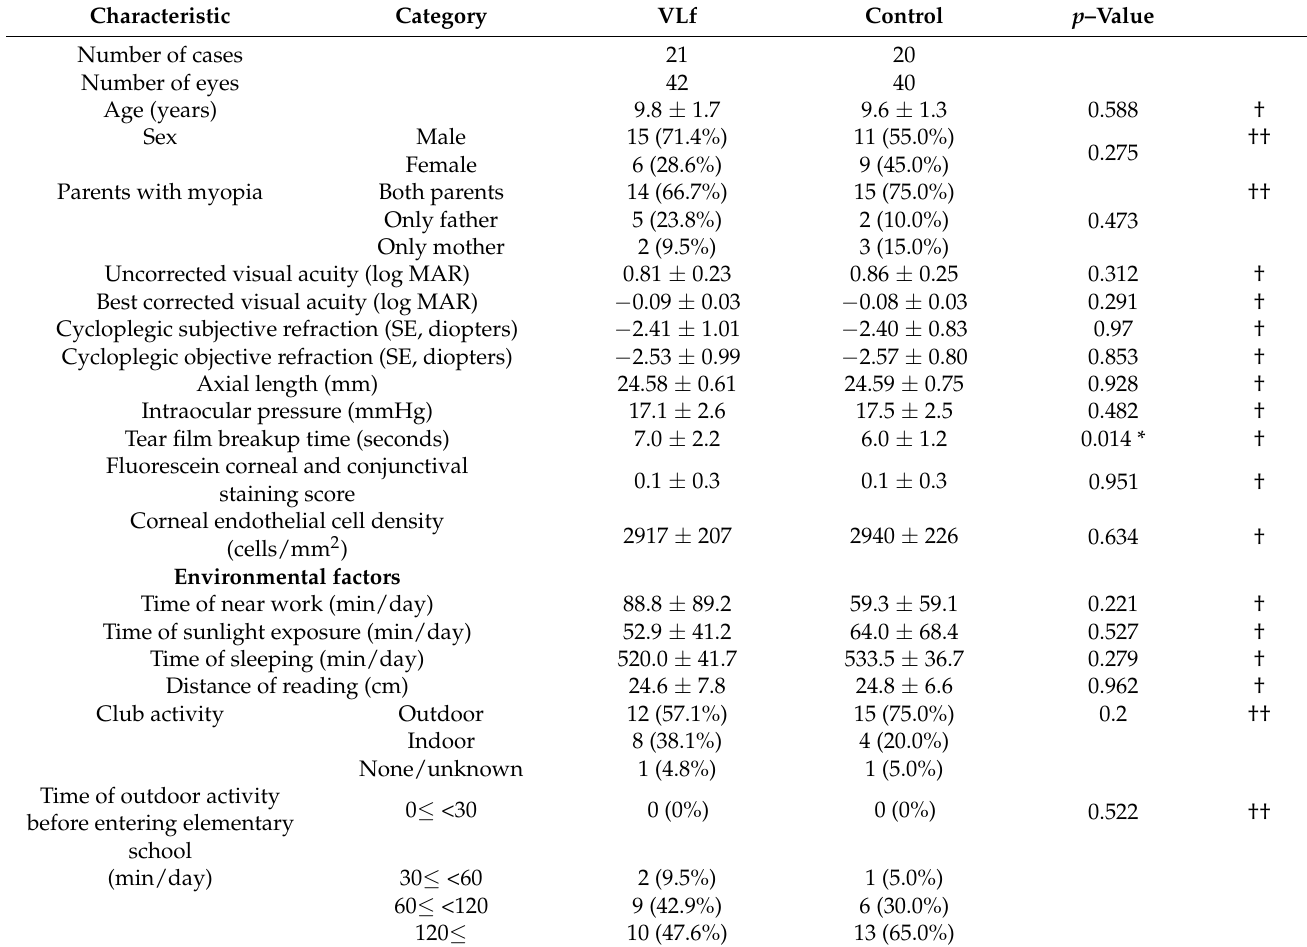
Table 1. Characteristics of the 82 eyes of 41